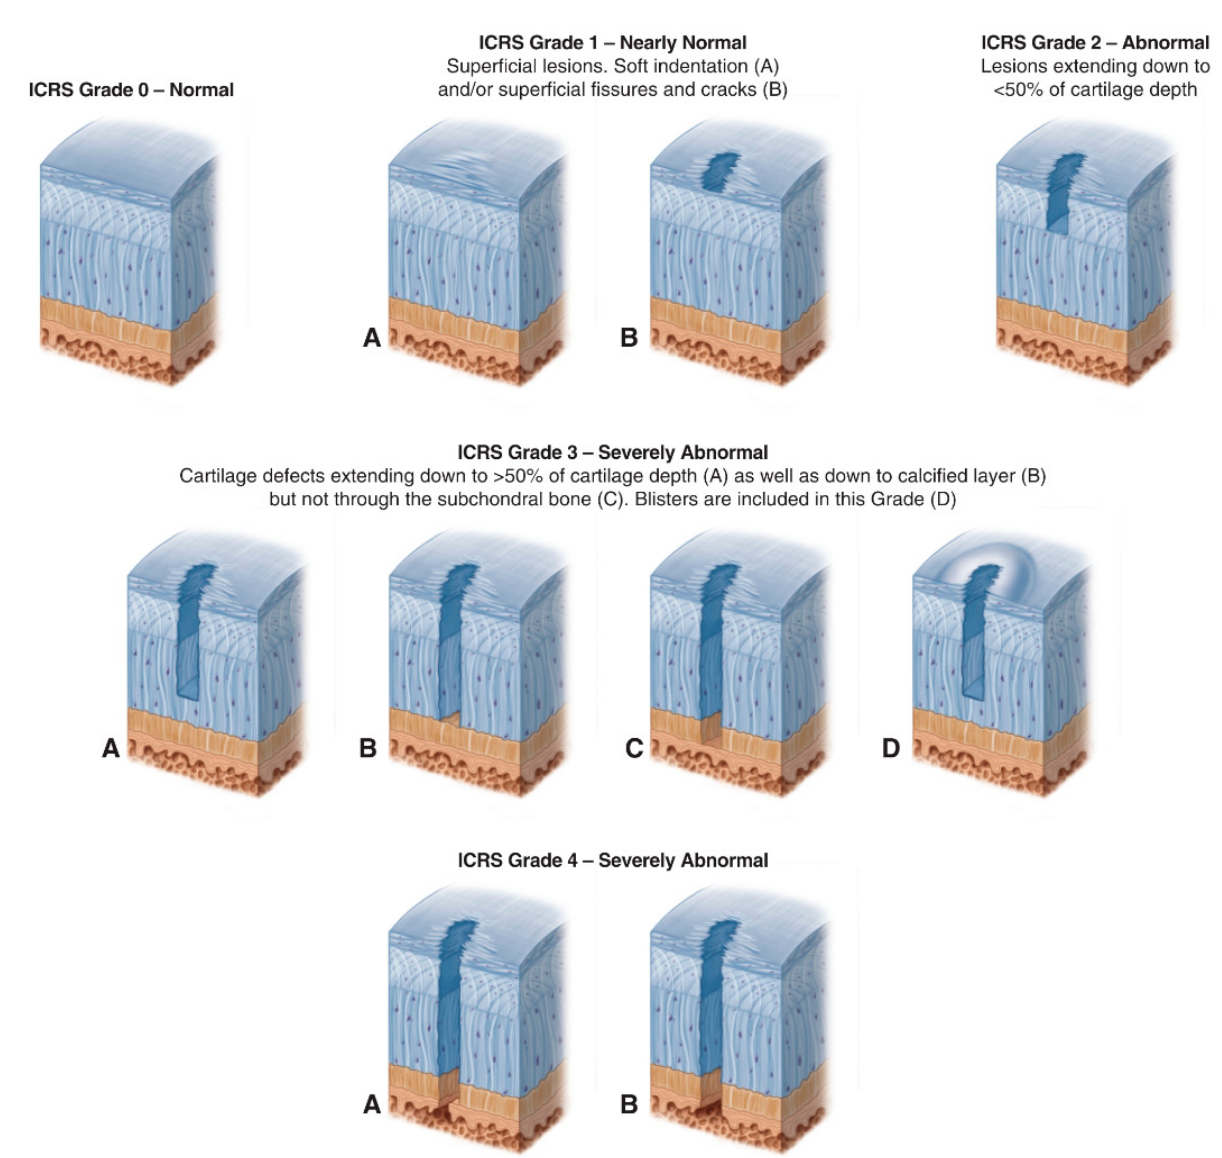
Figure 2. The International Cartilage Repair Society (ICRS) Cartilage Lesion Classification Method. Image reprinted with permission from the ICRS Cartilage Injury Evaluation Package (http://www.cartilage.org/, accessed on the 1 November 2021).